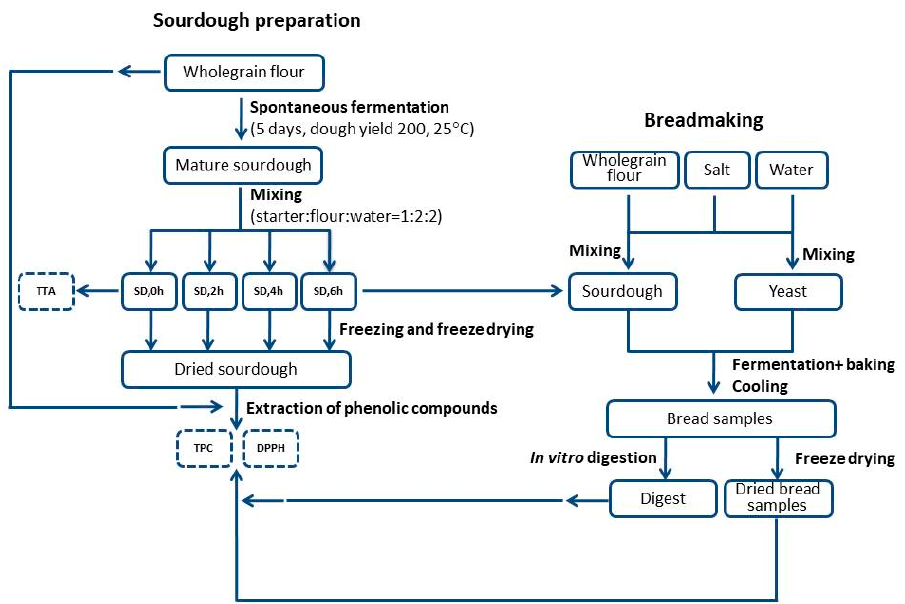
Figure 1. Scheme of experimental procedure used in this study. Abbreviations: SD—sourdough, TTA—total titrable acidity, TPC—total phenolic content, DPPH—antioxidant capacity according to DPPH method.